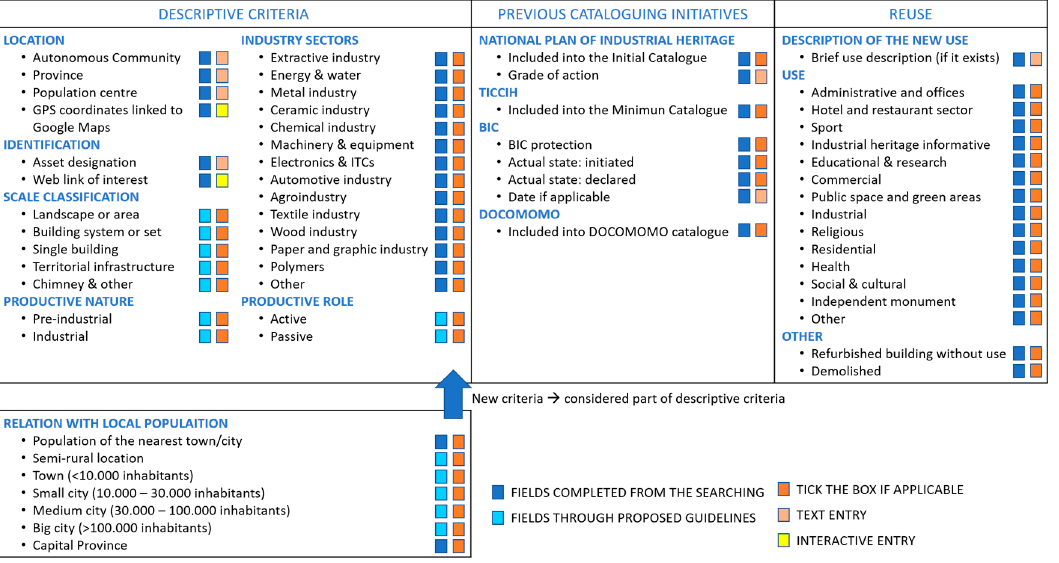
Figure 3. Criteria structure of the developed catalogue: information obtainment process and type of information.